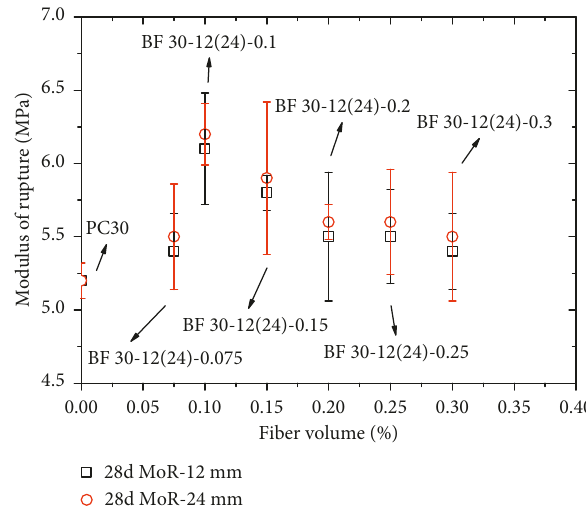
Figure 7: Effect of fiber length on the BFRC modulus of rupture (MoR) for specimens PC30 and BF 30-(12 ∼ 36)-0.1(0.15).